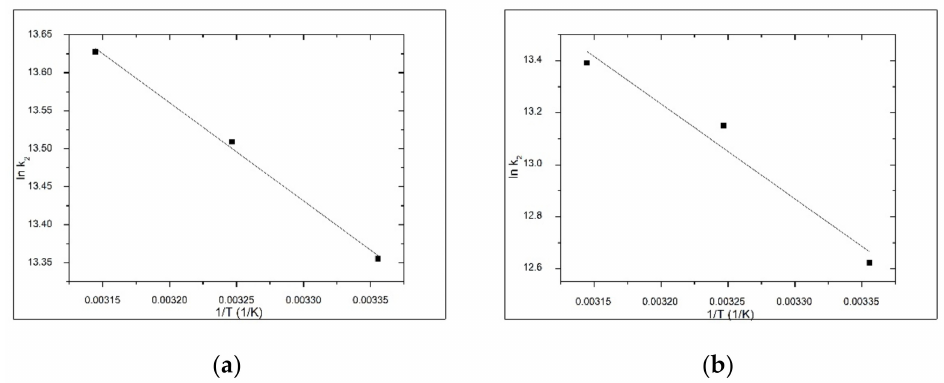
Figure 9. Arrhenius plot of the adsorption of As(V) onto functionalized materials ( a ) V-DEHPA-Fe and ( b ) VF-DEHPA-Fe.